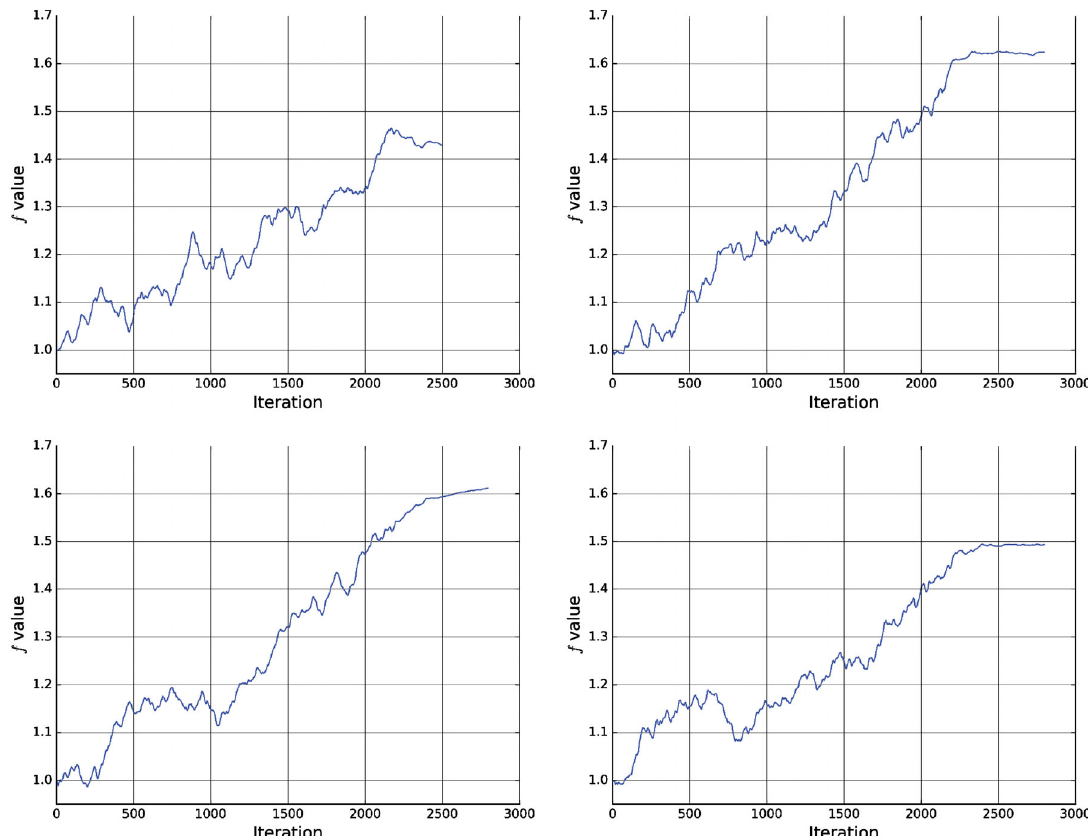
Fig. 7 Fluctuation of f during training for the general image parsing task, with identical initial network settings. Only changes in the first 3000 iterations are plotted here. The initial dilation value was 18. Due to the great variability during optimization, f will reach a range of values, instead of stopping at a specific